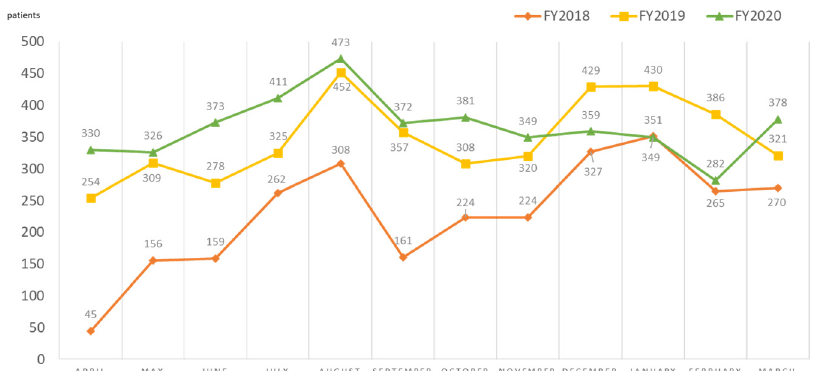
Figure 8. Trends in the monthly number of patients at Futaba Medical Center, FY2018-FY2020.